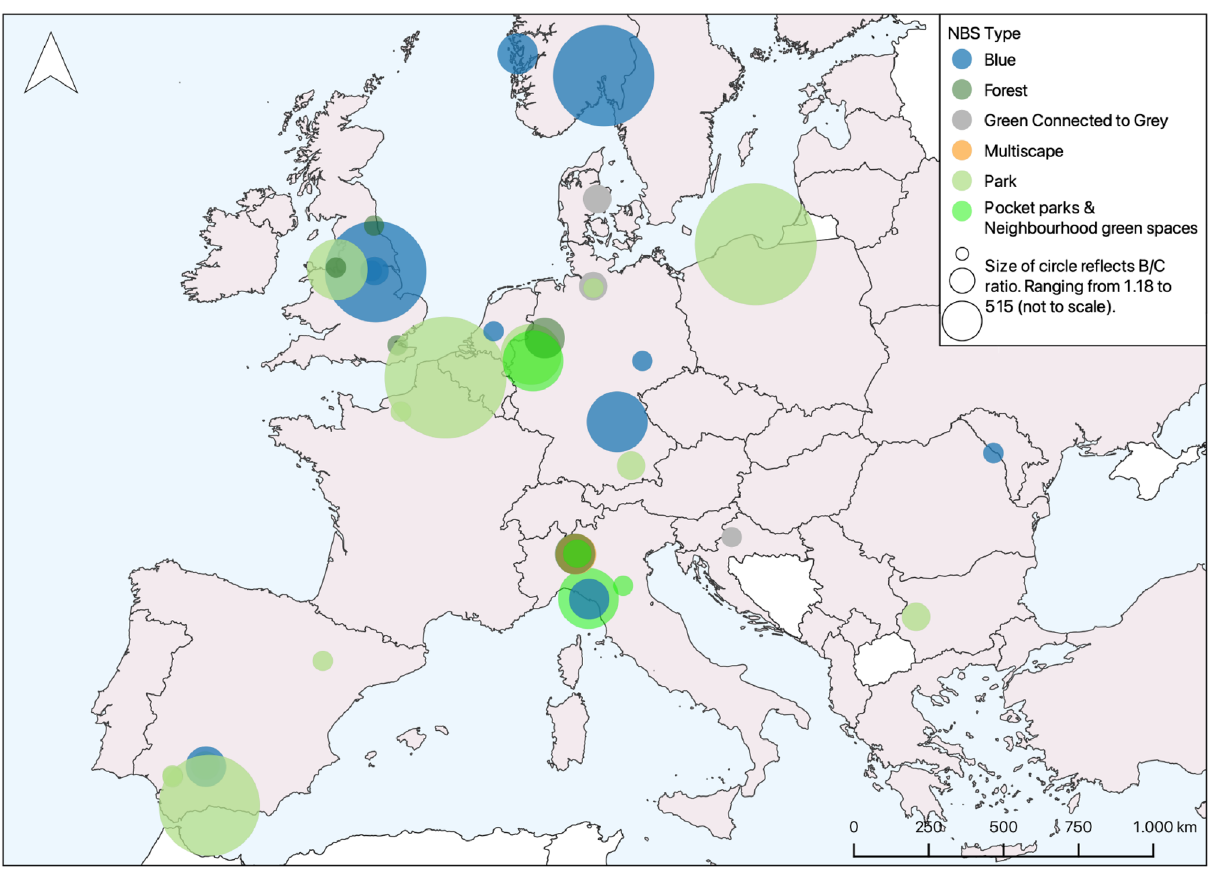
Figure 1. Spread of the selected NBS interventions across Europe and estimated social returns, by type of nature (log of benefit–cost ratio). Source : own calculation, map generated using open-source software QGIS version 3.24 (https:// qgis. org/ en/ site/ getin volved/ faq/ index. html).